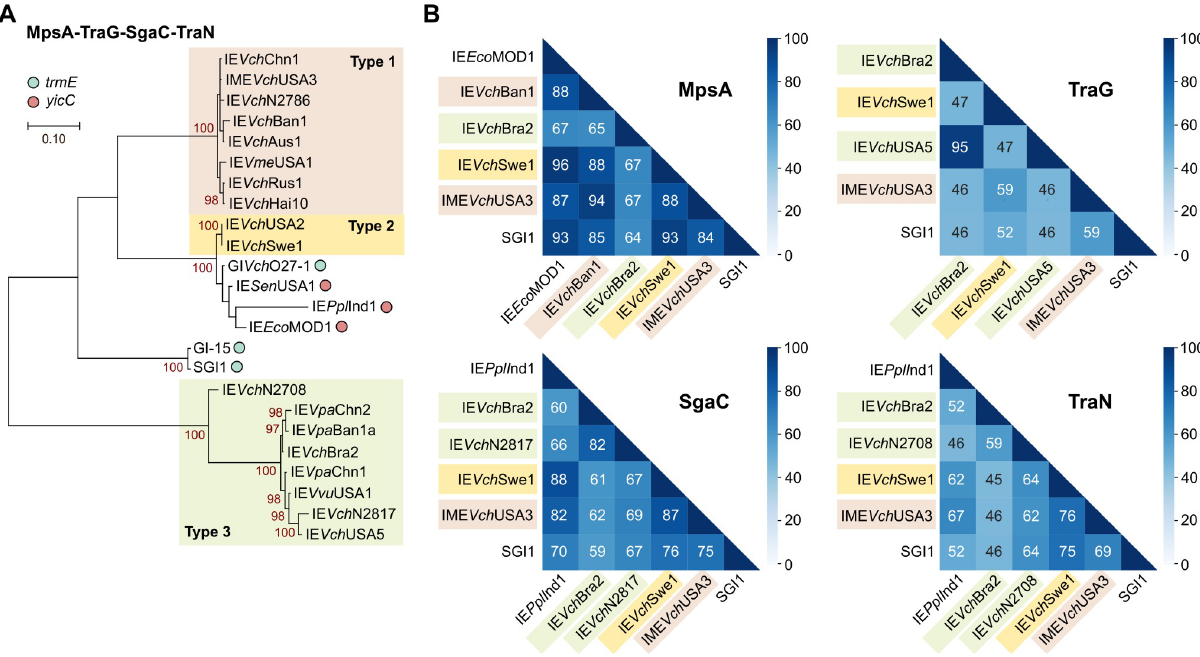
Fig 3. Conserved genes support three main lineages of dusA -specific SGI1-like IEs. (A) Maximum likelihood phylogenetic analysis of concatenated MpsA-TraG-SgaC-TraN. The tree is drawn to scale, with branch lengths measured in the number of substitutions per site over 2,637 amino acid positions. Taxa corresponding to IEs targeting trmE and yicC are indicated by a light blue circle and a red circle, respectively. All other taxa correspond to dusA -specific IEs. Phylogenetic relationships of MpsA, TraG, SgaC and TraN proteins are shown separately in S2 Fig. (B) Heatmaps showing blastp identity percentages of pairwise protein comparisons for representatives of MpsA, TraG, SgaC, and TraN. Proteins accession numbers and clusters are provided in S1 Table and S2 Dataset.